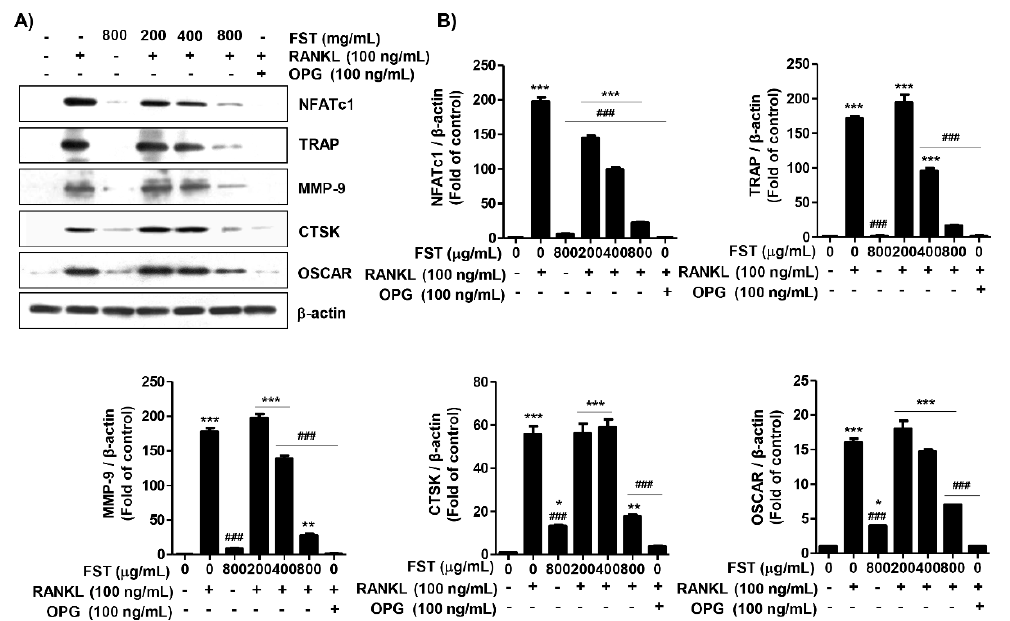
Figure 5. Inhibition of the RANKL-induced expressions of osteoclast-regulatory genes by FST in RAW 264.7 mouse macrophage-like cells. Cells were co-treated with various concentrations of FST or 100 ng / mL OPG in the presence or absence of 100 ng / mL RANKL for 5 days. ( A ) The expression levels of osteoclast-regulatory proteins were assessed by Western blot analysis. β -actin was used as the internal control. The results shown are representative of three independent experiments. ( B ) Densitometry quantifications of protein expression were measured by ImageJ. Statistical analyses were conducted using analysis of variances. * p < 0.05 and *** p < 0.0001 when compared to control. ### p < 0.0001 when compared to RANKL treatment. RANKL: receptor of activator of nuclear factor kappa-B ligand; FST: fermented sea tangle extract; OPG: osteoprotegerin; CTSK: cathepsin K ; MMP-9: matrix metalloproteinase-9; NFATc1: nuclear factor of activated T cells c1; OSCAR: osteoclast-associated receptor; + : cells treated the reagent; -: cells untreated the